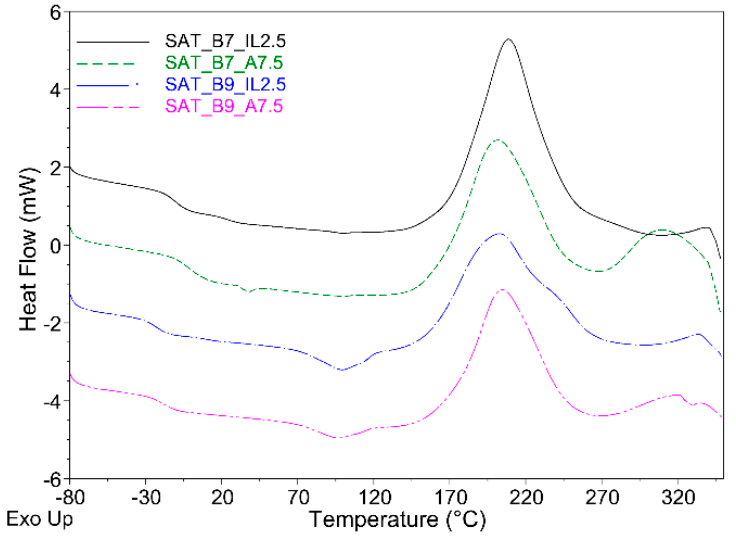
Figure 11. DSC thermograms of UV-cross-linked SATs. Table 5. Thermal parameters of the thermally cured SATs and the cross-linking degree (DSC data). SAT